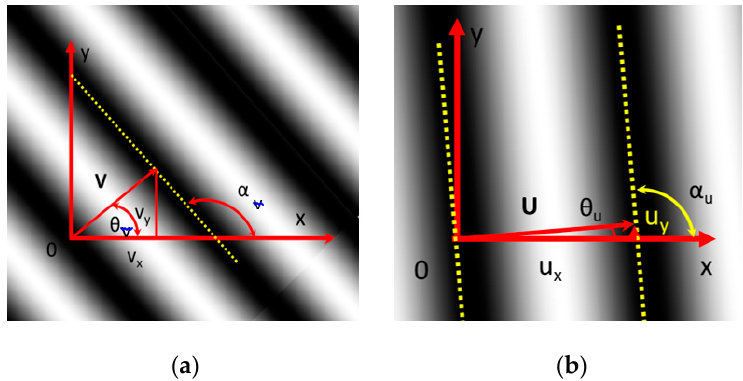
Figure 2. ( a ) Example of a local pattern of vertical displacement V (fringes in the undeformed condition are horizontal) obtained for large deformations and rotations; ( b ) Example of a local pattern of horizontal displacement U obtained for small deformations and rotations.